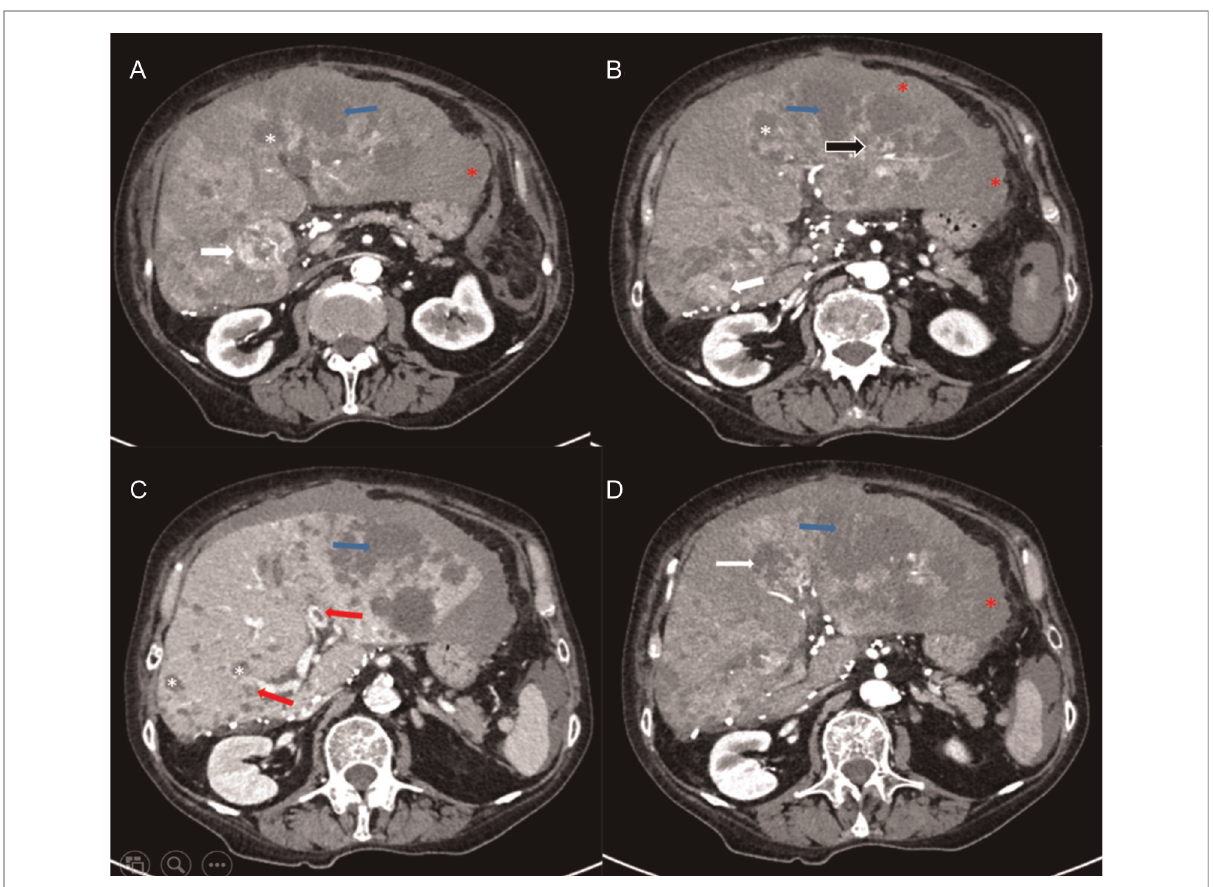
FIGURE 1 Abdominal axial CT images of the liver in arterial ( A and B ) and venous phase ( C and D ) showing multiple liver lesions of various characteristics (white arrow-HCC; black arrow- ruptured HCC; white asterisk-simple liver cysts; blue arrow-abscess; red asterisk-hematoma; red arrow-portal vein